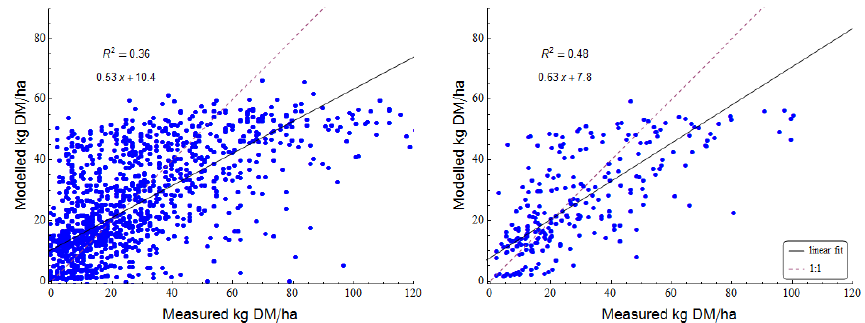
Figure 4. Scatter plot of modelled vs. measured pasture growth for validation sites. Measured and modelled daily growth rates (kilograms of dry matter per hectare) for all sheep/beef validation sites compared at individual cutting intervals (left) and monthly averages over 3 years (right). Correlation coefficient R 2 = 0 . 36 (RMSE = 20.9) and 0.48 (RMSE = 15.9), respectively. Type 2 linear regression model shown is y = 0 . 53 ± 0 . 040 x + 10 . 4 ± 1 . 2 (left) and y = 0 . 63 ± 0 . 085 x + 7 . 8 ± 2 . 5 (right). Reported errors are 2 σ . The 1:1 line is drawn for